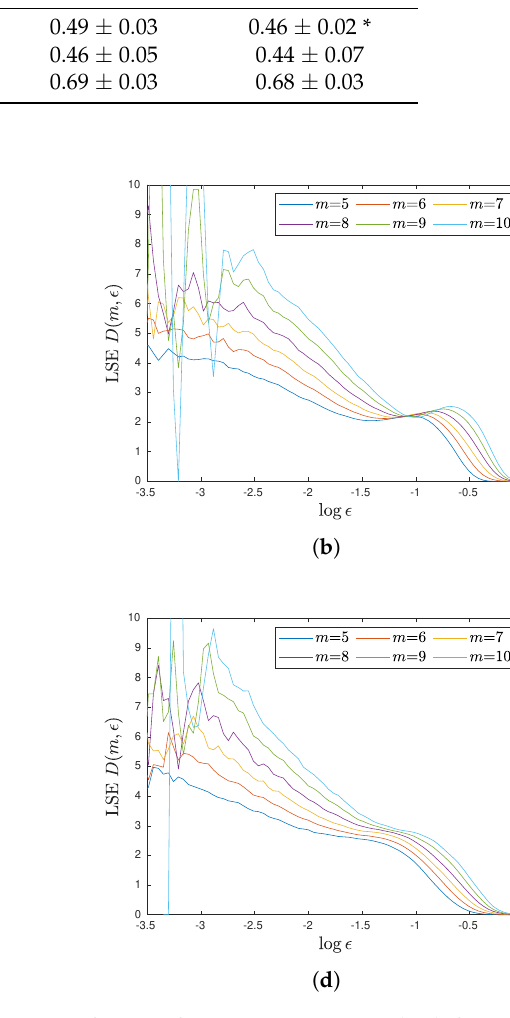
Figure 4. LSEs of the trunk acceleration data for one subject in the anterior–posterior (AP) direction with different embedding dimensions ( m = 5, . . . ,10) in ( a ) condition 1 and ( b ) condition 3. LSEs of the trunk acceleration data for another subject in the AP direction in ( c ) condition 1 and ( d ) condition